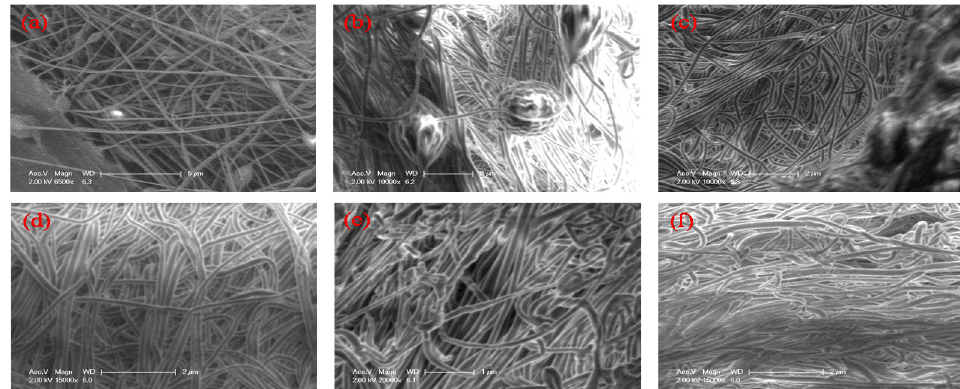
Figure 3. SEM (scanning electron microscope) image of PAN nanofiber samples with different experimental conditions: ( a ) flow rate control of 0.1 mL/h; ( b ) flow rate control of 0.2 mL/h; ( c ) voltage control of 12 kV; ( d ) voltage control of 14 kV; ( e ) distance between syringe tip and collector plate of 23 cm; and ( f ) distance between syringe tip and collector plate of 18 cm.